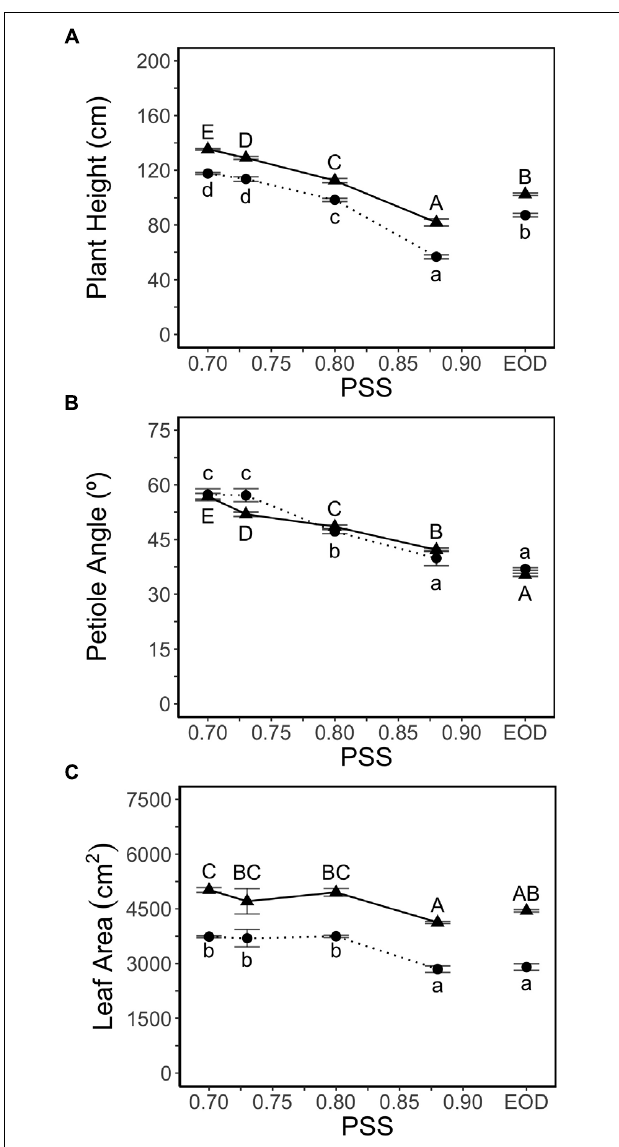
FIGURE 1 | (A) Height, (B) average petiole angles of all leaves (upper angle between petiole and stem) and, (C) leaf area of tomato plants in relation to four levels of PSS and an EOD-FR treatment (EXP1: • , lower case letters; EXP2: (cid:78) , capital letters). Plants had been grown for 4 weeks at the different light treatments. Error bars represent SEM ( n = 3). Different letters indicate significantly different means ( P < 0.05).